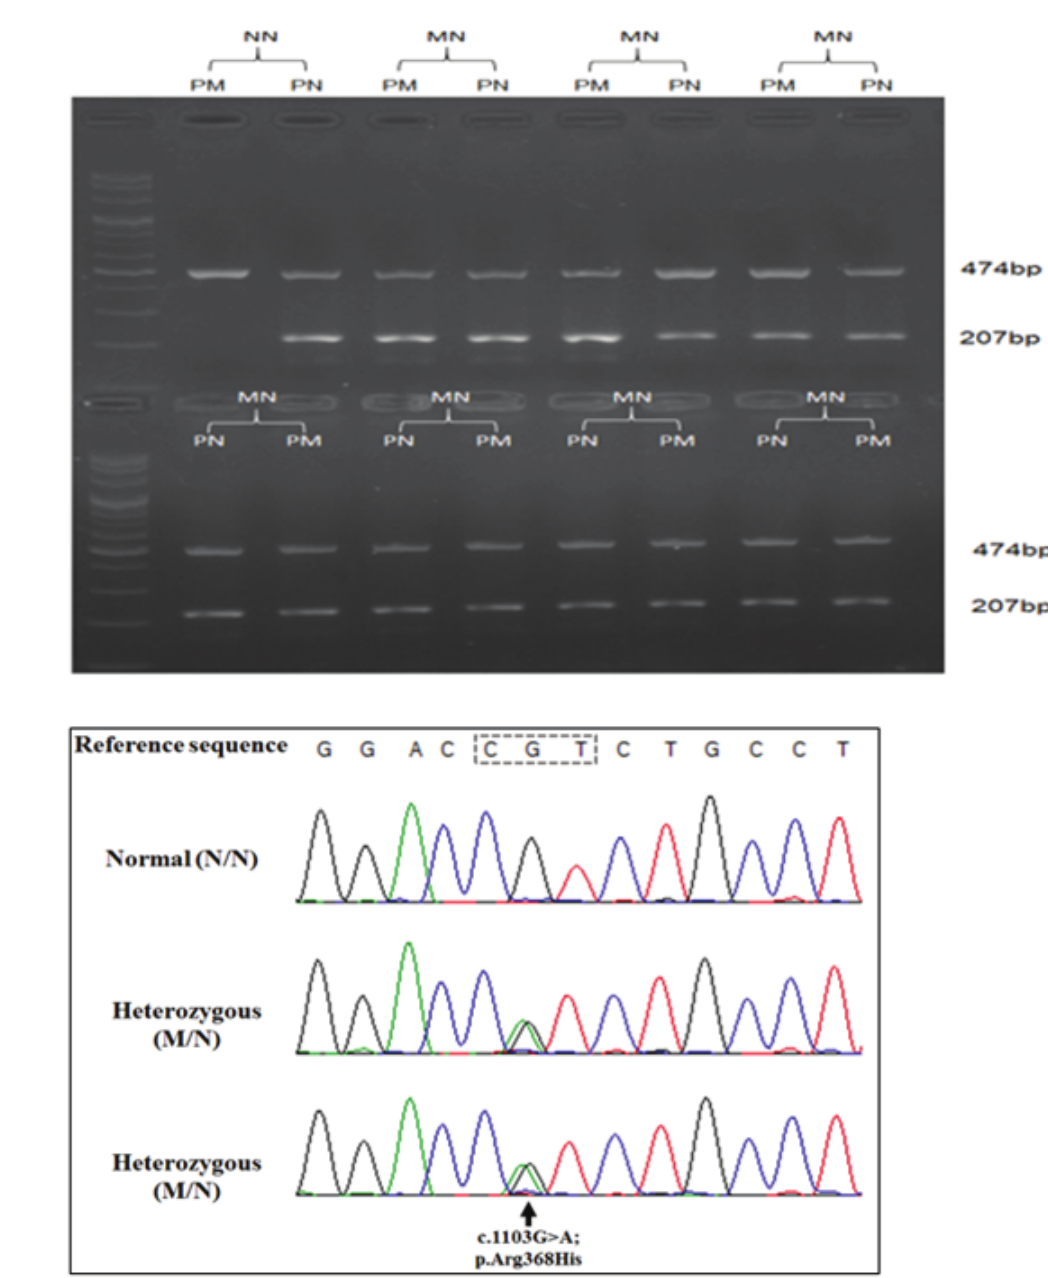
Figure 2. P.Arg368His mutation in CYP1B1 caused by the c.1103G > A mutation in exon 3 of the encoding gene. (A) Electrophoresis patterns of PCR products relevant to screening of p.Arg368His by ARMS protocol. Two patterns are presented for each individual, one that represents products obtained with primer specific for normal allele (PN) and another that represents products obtained with primer specific for mutated allele (PM). The 474 bp fragment is the control fragment. The 207 bp fragment is from CYP1B1 . NN, electrophoresis pattern of PCR products of individual known to be homozygous for the normal allele; MN, electrophoresis patterns of seven of representative individuals from east of Guilan who were carriers of the p.Arg368His mutation. (B) DNA sequence chromatograms of a wild type CYP1B1 genotype (top) and two heterozygous genotypes for the c.1103G > A mutation that causes p.Arg368His